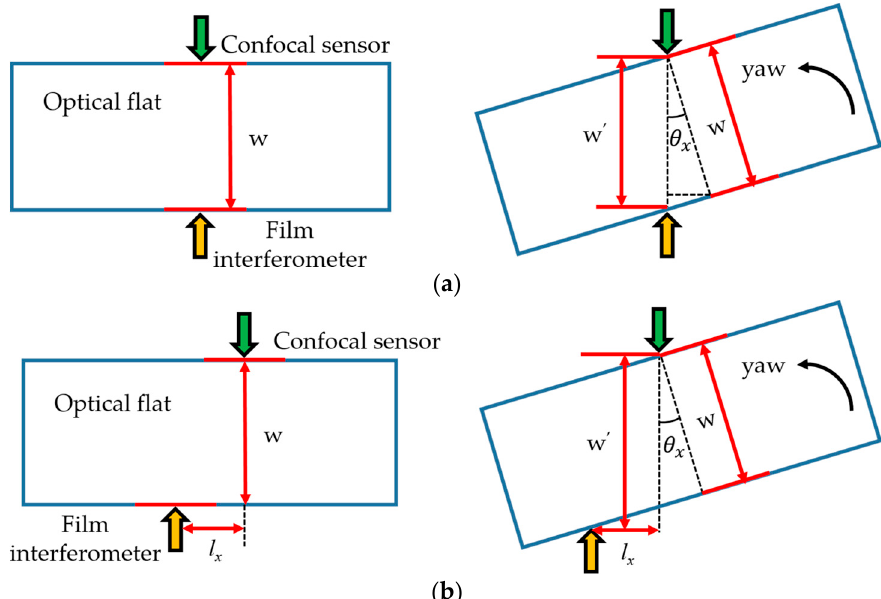
Figure 14. The relationship between the horizontal alignment of the measurement locations and the measurement deviation: ( a ) the measurement locations were properly aligned horizontally; ( b ) the measurement locations were not properly aligned.